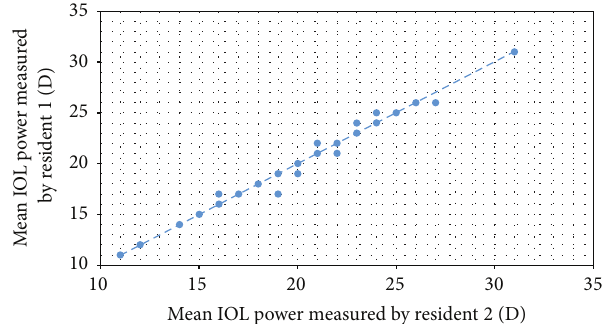
Figure 1: Correlation of mean IOL power measurements performed by both residents using the SRK/T